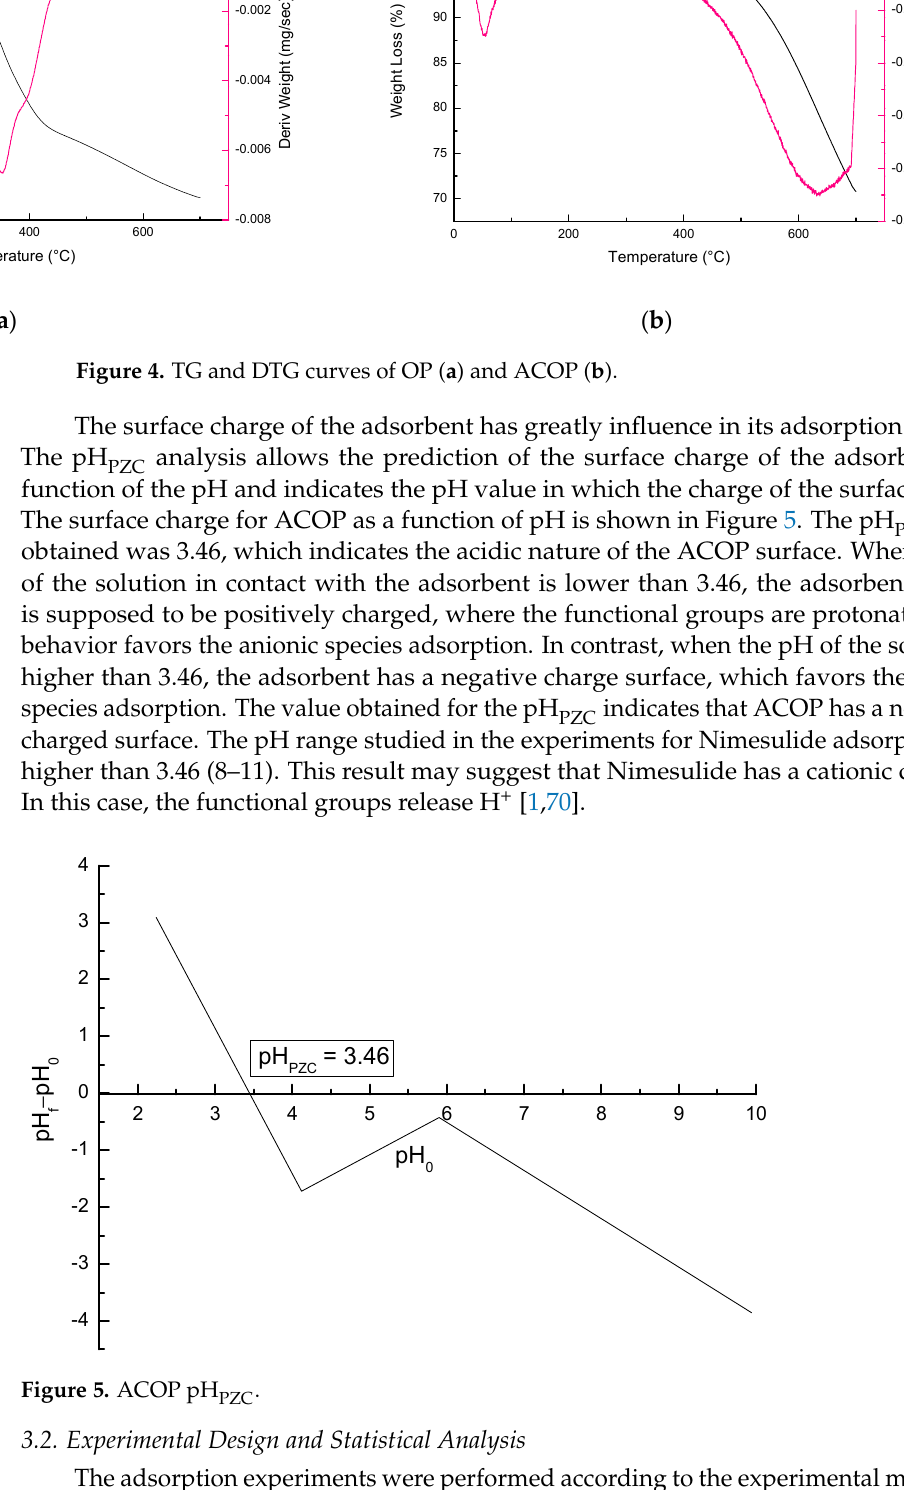
Figure 5. ACOP pH (cid:2900)(cid:2910)(cid:2887) .